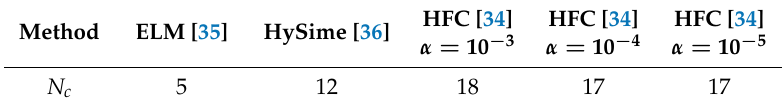
Table 6. Number of endmembers estimated by the use of ELM, hyperspectral signal identification by minimum error (HySime) and